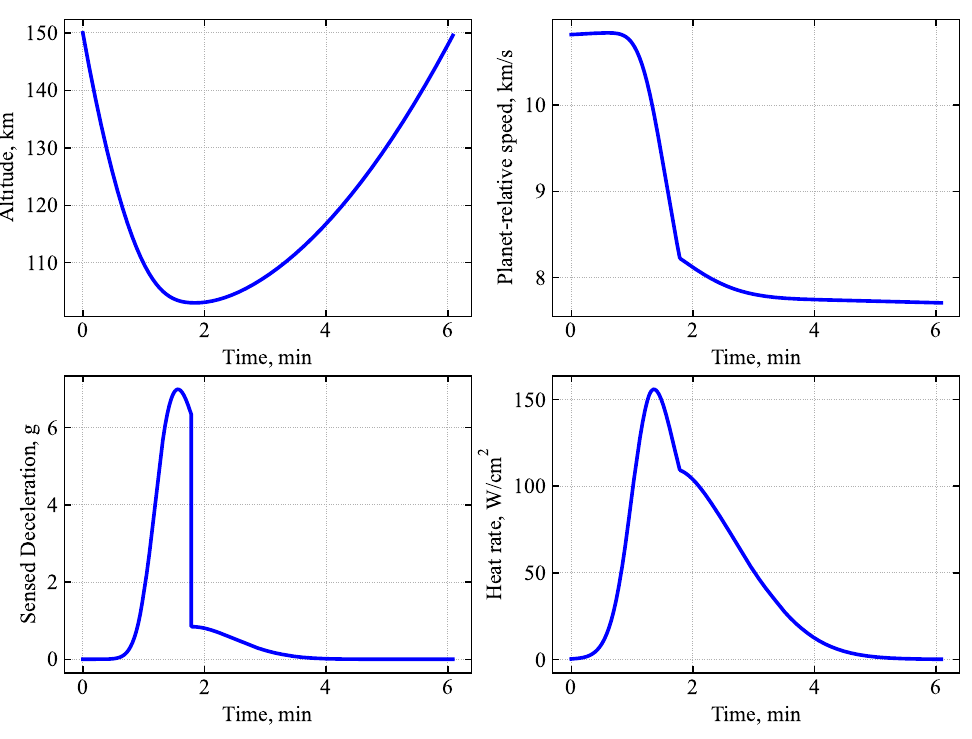
Figure 18. Nominal Venus small satellite aerocapture trajectory for a vehicle with β 1 = 20 kg/m 2 , β 2 / β 1 = 7.5, R N = 0.235 m entering at atm. relative to EFPA = − 5.20 deg. Target apoapsis = 2000 km.